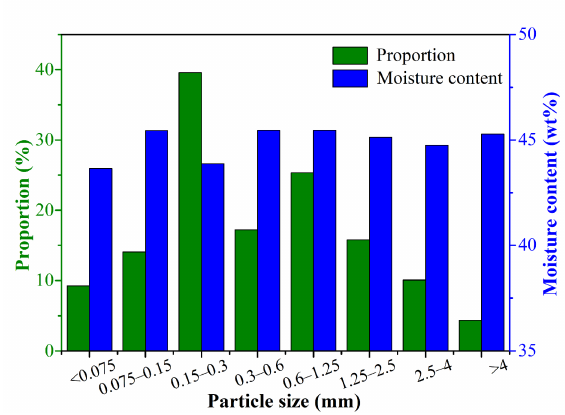
Figure 3. Particle size distribution and corresponding moisture content distribution of